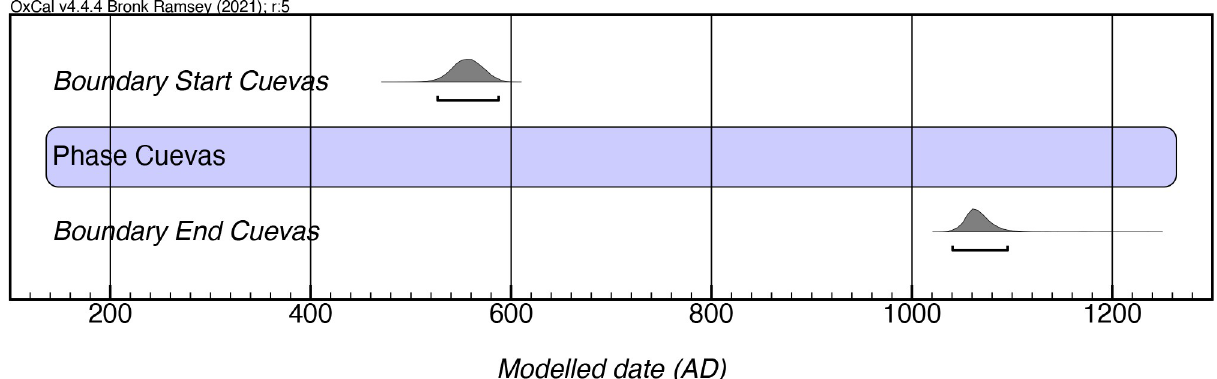
Fig 9. Modeled date ranges for the Cuevas style in Puerto Rico. Probability distributions indicate modeled 2 σ (95.4%) confidence intervals for beginning and end of phase.